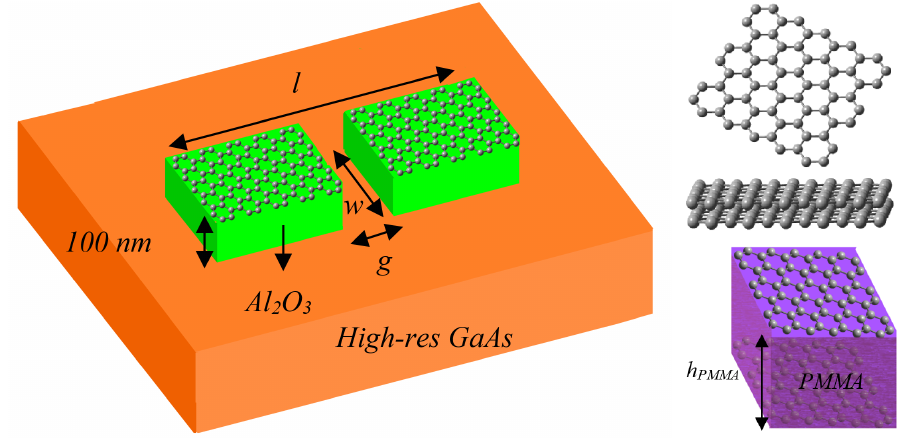
Figure 1. Configuration of dipole antenna by considering monolayer graphene (MLG, top ), few-layer graphene (FLG, middle ), and a graphene stack (GS, bottom